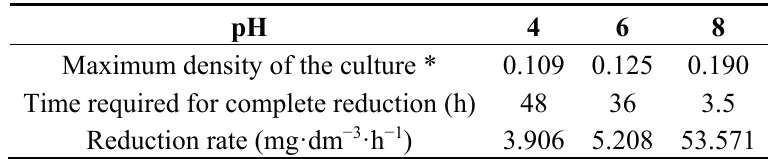
Table 2. Growth of Shewanella sp. O23S during dissimilatory reduction of arsenate at 22 °C under various pH